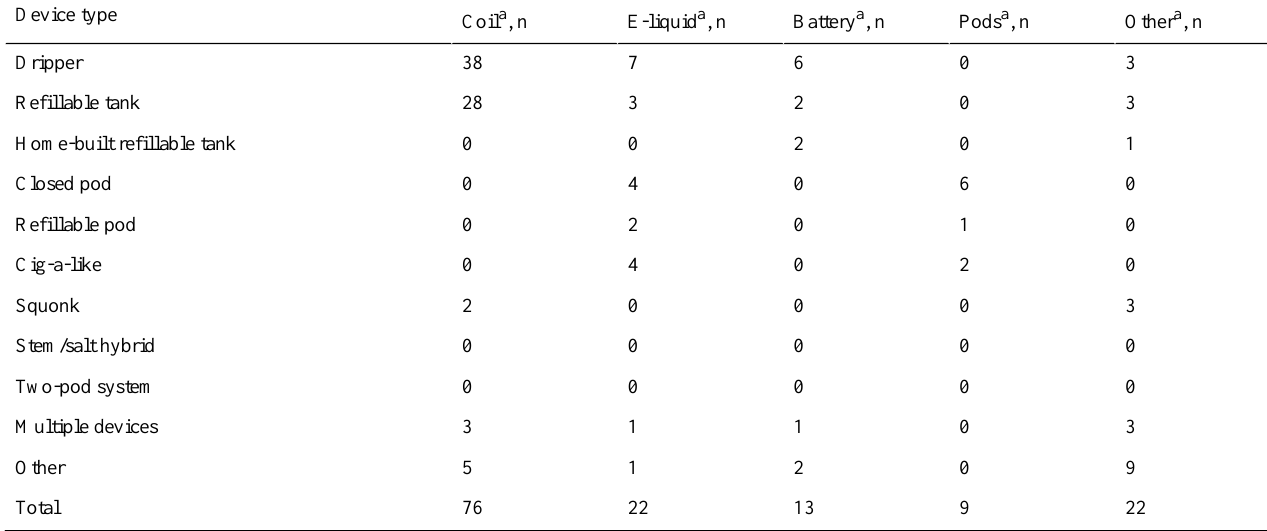
Table 3. Modification by device